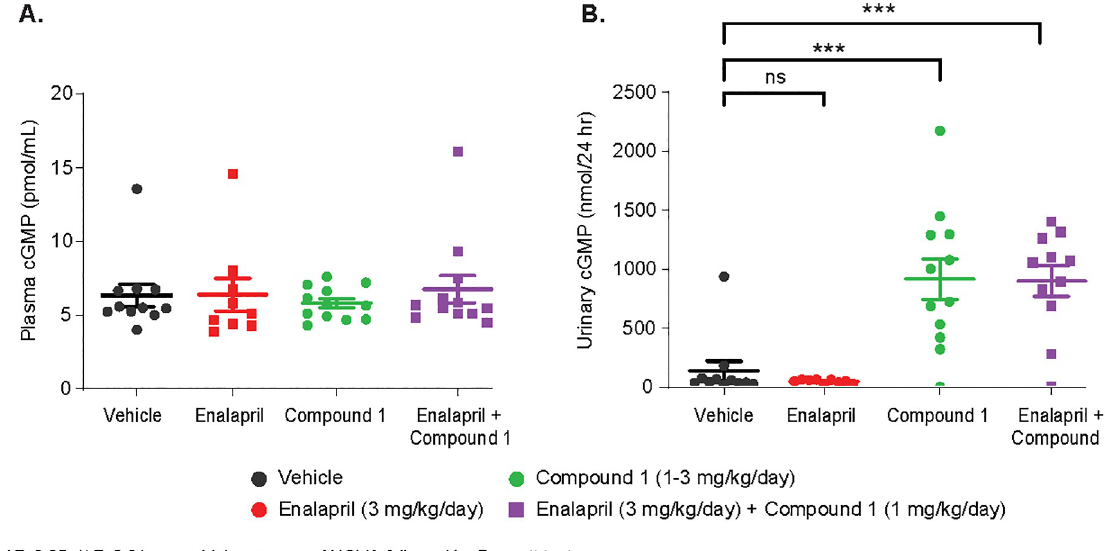
Fig 11. Effect of Compound 1 on plasma and urinary cGMP. Plasma levels of cGMP (A) are similar among treatment group. Urinary cGMP (B) is significantly increased in compound 1 treated alone or combination of compound 1 and enalapril vs. that in vehicle control treated. �� P < 0.01, compared to Vehicle control, one-way ANOVA, followed by Dunnett’s test.